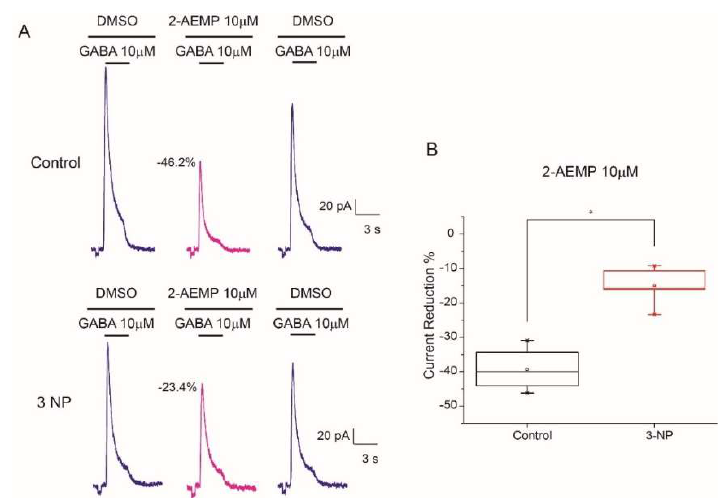
Figure 9. 2-AEMP effect on GABA induced current. ( A ) Representative traces of the GABA induced current (10 µM) with a co-application of 2-AEMP (10 µM) in Control (top) and 3-NP groups (bottom). GABA administration was co-applied with DMSO used as an excipient for 2-AEMP. ( B ) Box plots illustrating the current peak reduction of I GABA induced by the GABA C antagonist. MSNs from the 3-NP group were significantly less inhibited by the 2-AEMP compared to control neurons (t 7 = −6.015, p < 0.001).